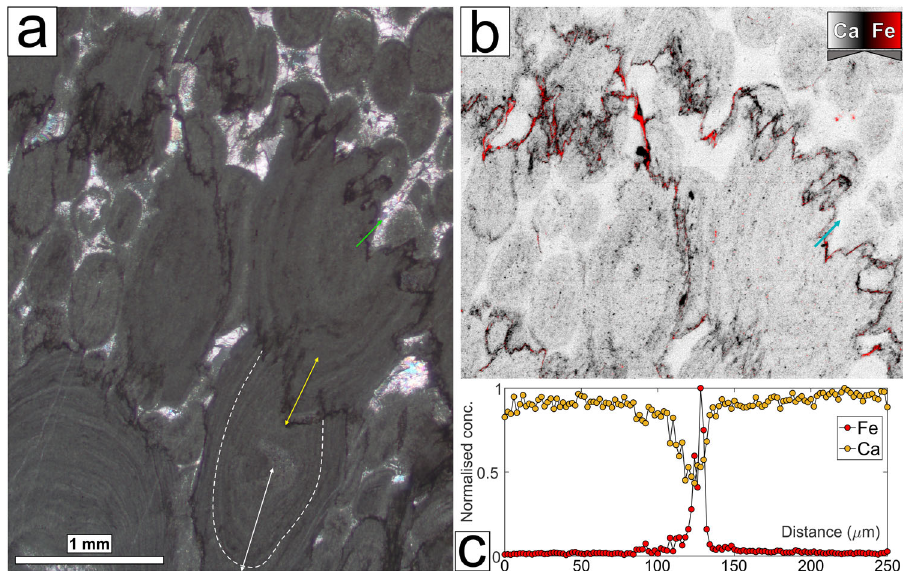
Fig. 2 Typical stylolites. a Transmitted-light micrograph with crossed polarisers of an oolitic grainstone of the Gudman Oolite 25 . The serrated, black zones are stylolites, which clearly dissolved the deformed, ellipsoidal ooids (dark-grey grains). This image demonstrates that stylolite tooth amplitude presents a lower-bound estimate to dissolution. The dashed white line traces a concentric primary growth layer of a dissolved ooid. The white arrow denotes the ooid long axis, which extends beyond the lower image margin. The stylolite at the upper tip of the ooid exhibits a maximum amplitude (yellow arrow) that is considerably smaller than the portion of the upper long axis that has been removed by dissolution. This effect is even more pronounced in the larger ooid above the discussed stylolite interface. The green arrow marks the location for the concentration pro fi le shown in ( c ). b Micro-scale XFM map of the elements Ca (grey scale) and Fe (red scale) of the upper part of the micrograph seen in ( a ). Saturated colours indicate high element concentrations. Strongly serrated stylolites are characterised by low Ca concentrations (black colours) and high Fe concentrations (bright red colours). The blue arrow marks the position of the concentration pro fi le in ( c ) and is 250 μ m long. c An elemental cross-section across a stylolite shows that Ca is depleted by ~55% while Fe is enriched about 30 times within this stylolite. Here and in all following normalised elemental pro fi les, error bars are smaller than symbol size and thus not shown.